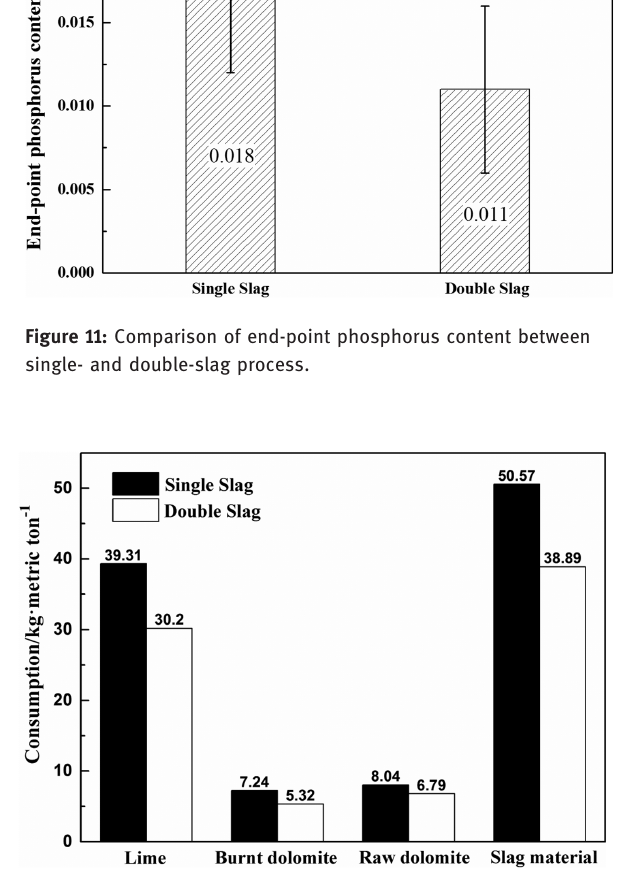
Figure 12: Comparison of slag material cost between single- and double-slag